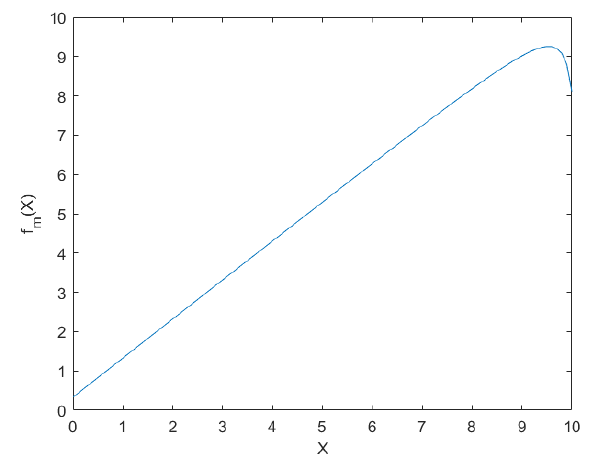
Figure 3. Function 𝑓 𝑚 (𝑋) for case 3, when μ = 9.5 , 𝑘 = 1 . Figure 3. Function f m ( X ) for case 3, when µ = 9.5, k =